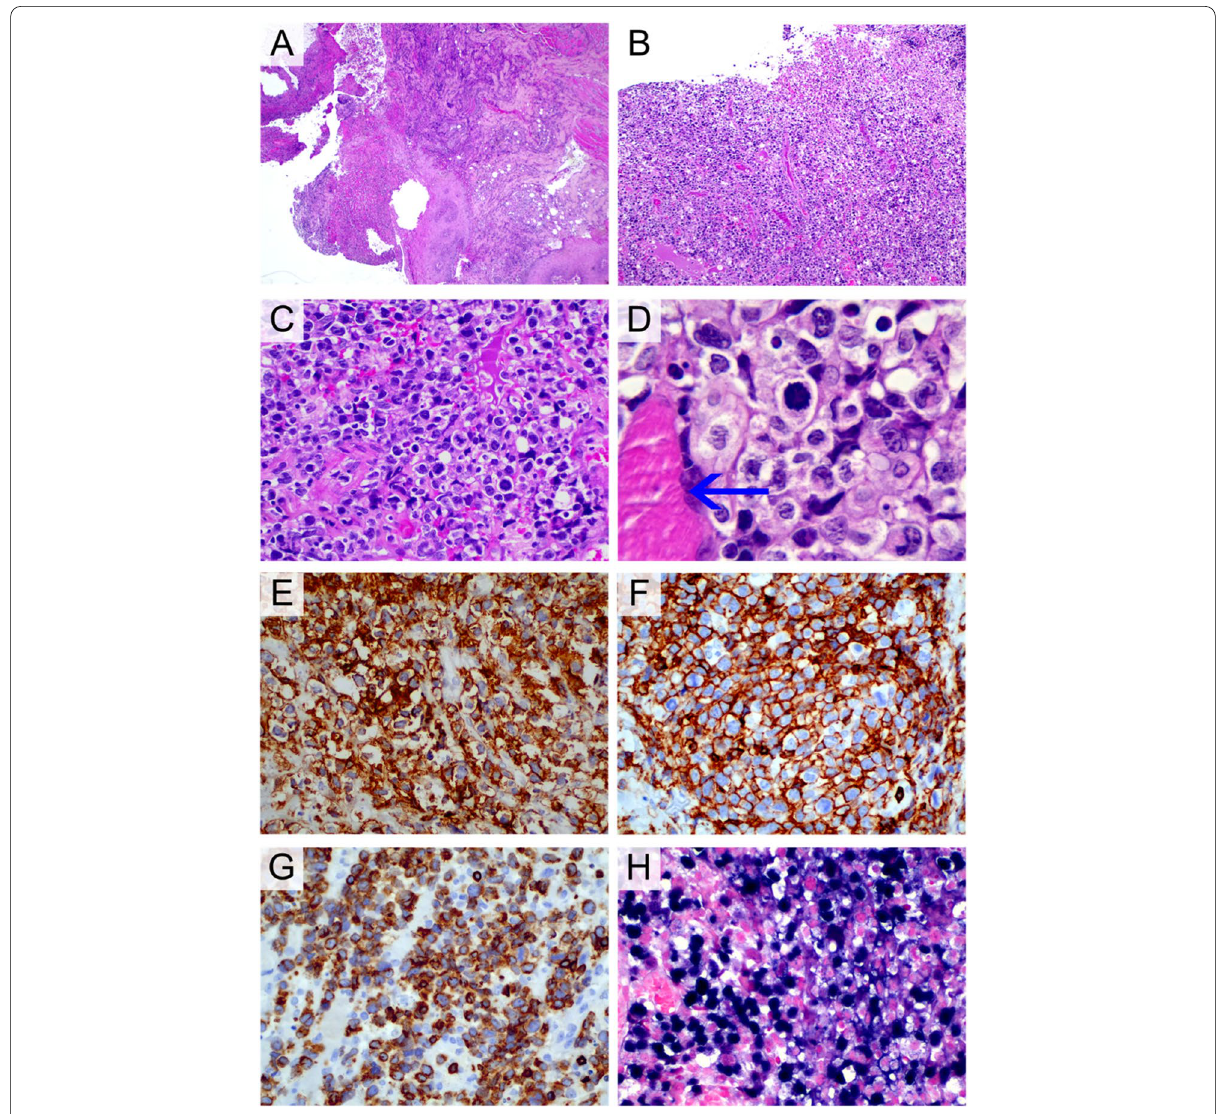
Fig. 3 Histology of the lesion. A Low-power photomicrograph of ulcerated nasal mucosa and submucosa ( 40). B Photomicrograph of ulcerated × mucosal surface and underlying lymphoid infiltrate ( 100). C Dense atypical lymphoid infiltrate at high power ( 400). D Malignant lymphoid × × infiltrate between skeletal muscle fibres (blue arrow) at high power ( 1000). E Immunohistochemistry (IHC) shows membrane positivity of tumour × cells for CD45 ( 400). F CD56 ( 400). G IHC shows cytoplasmic positivity for CD3 ( 400). H EBV in situ hybridisation shows strong nuclear positivity × × × in tumour cells